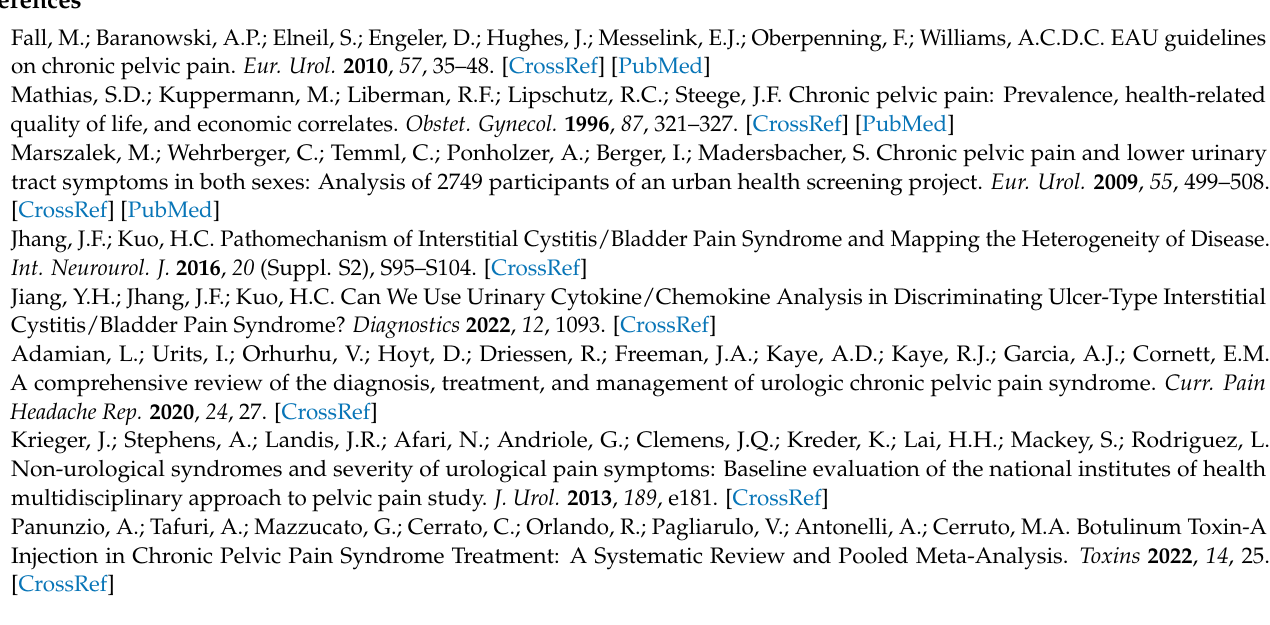
Table S2: Comparison between the titer measured and the titer declared for PEA, procyanidins, and total lipids in the three raw materials. Table S3: Expression of GRO alfa, GRO a/b/g, and GN-CSF reported as fold-changes compared to control (cells treated with medium conditioned only with the inflammatory stimulus, E. coli ) after treatment of bladder urothelium cells with the three functional ingredients and their mixture at different concentrations. * indicates statistical significance set at p < 0.05 for the comparison between the mixture and each ingredient singularly